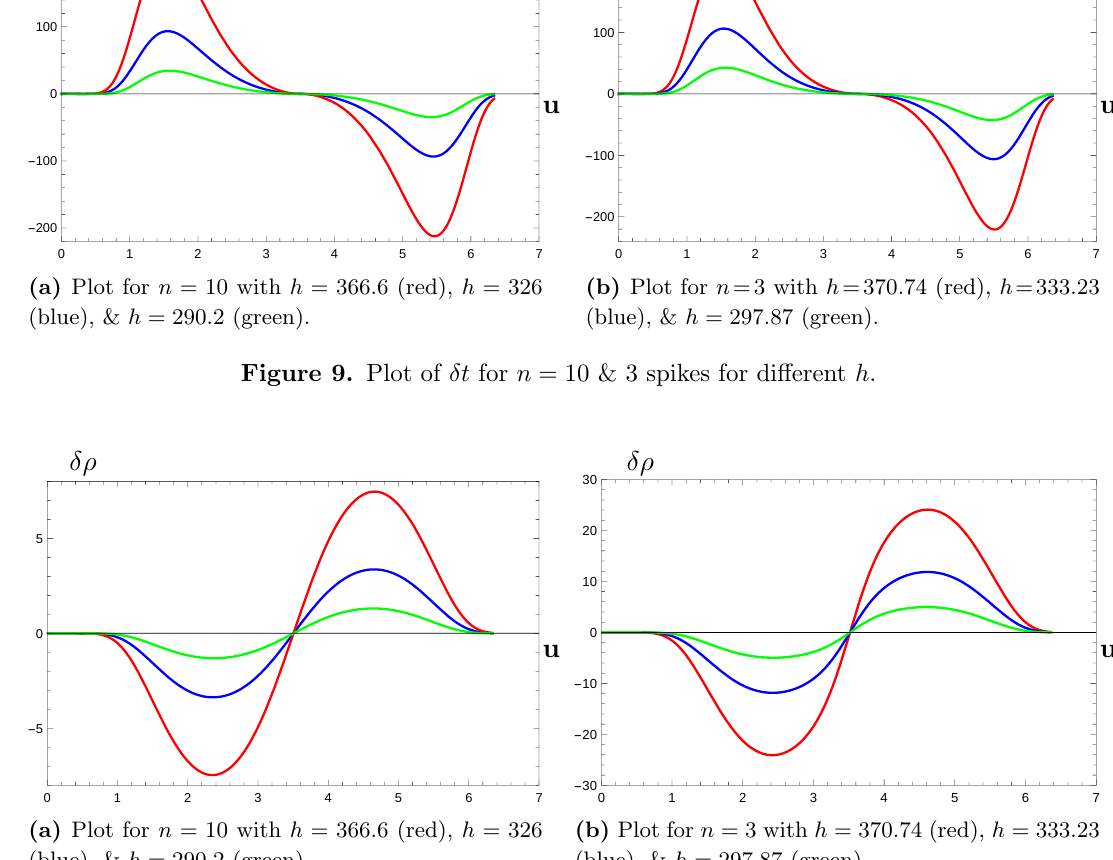
(a) Plot for n = 10 with h = 366 : 6 (red), h = 326 (b) Plot for n = 3 with h = 370 : 74 (red), h = 333 : 23 (blue), & h = 290 : 2 (green). (blue), & h = 297 : 87 (green). Figure 10. Plot of (cid:14)(cid:26) for n = 10 & 3 spikes for di(cid:11)erent h